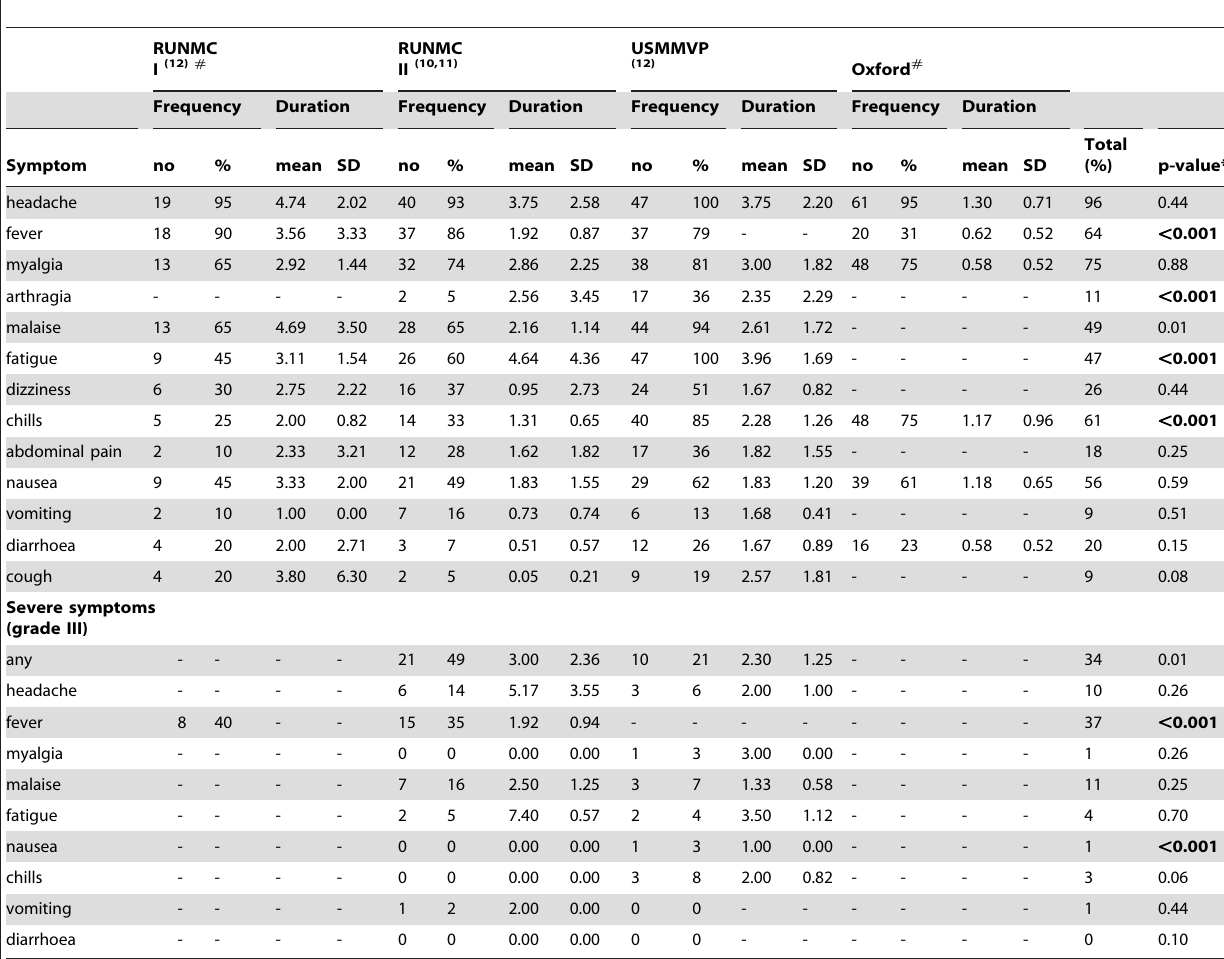
Table 2. Adverse event frequency and duration for three different